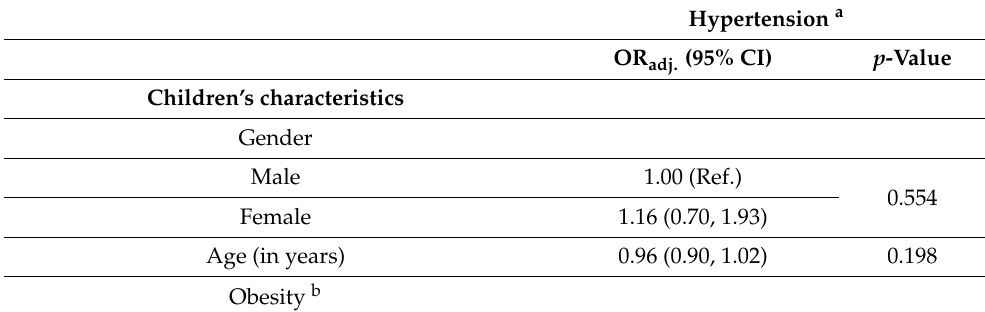
Table 5. Summary results of the hierarchical logistic regression of hypertension in children with intellectual